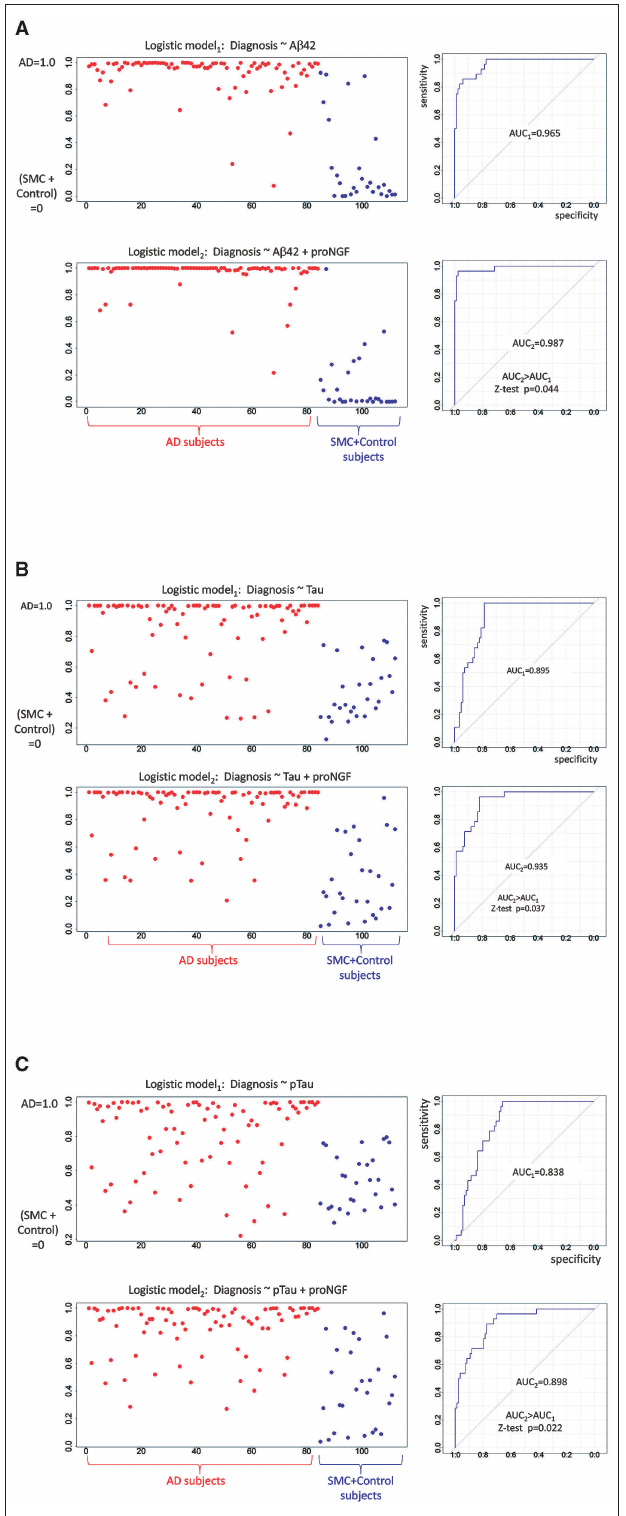
FIGURE 4 | Diagnostic predictions of logistic models: binarized response variable (AD = 1 vs. SMC + control = 0) is predicted by standardized A β 42